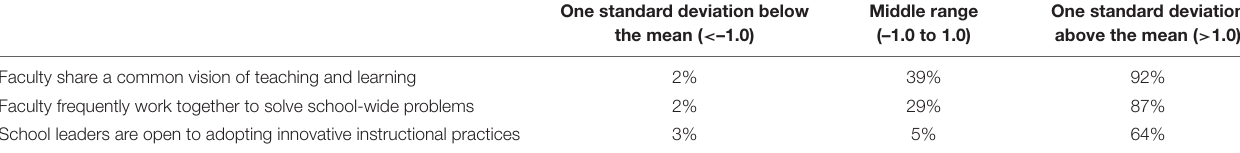
TABLE 3 | Average responses to sample items by composite score.